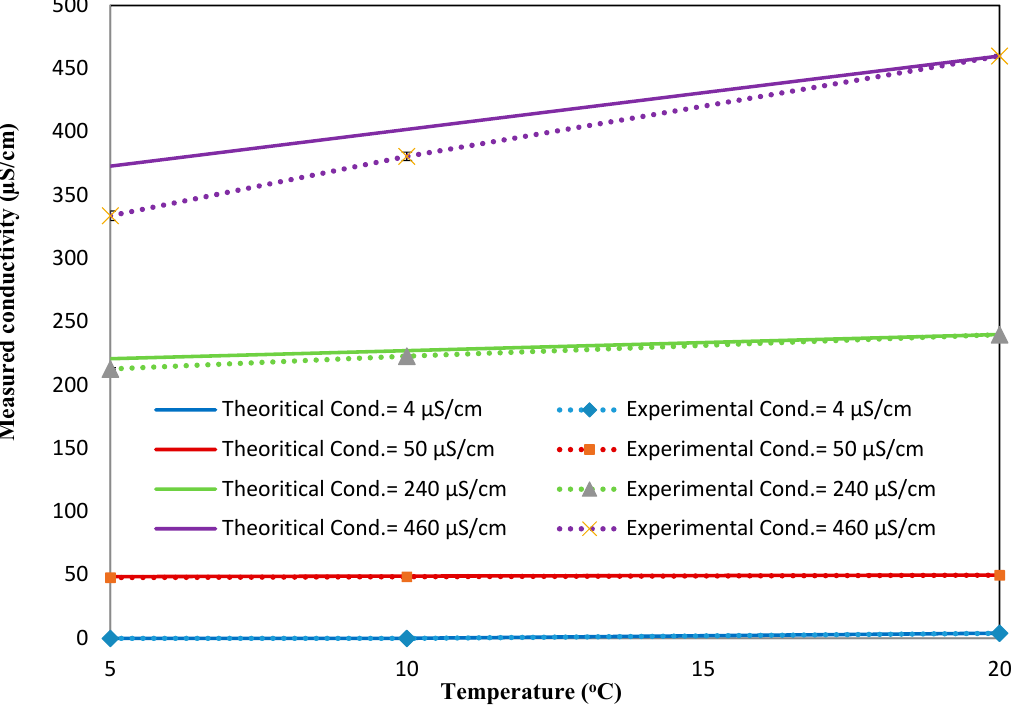
Figure A7. Effect of temperature on the response of the conductivity sensor compared to the theoretical values (both experimental and theoretical values were obtained at the static condition).